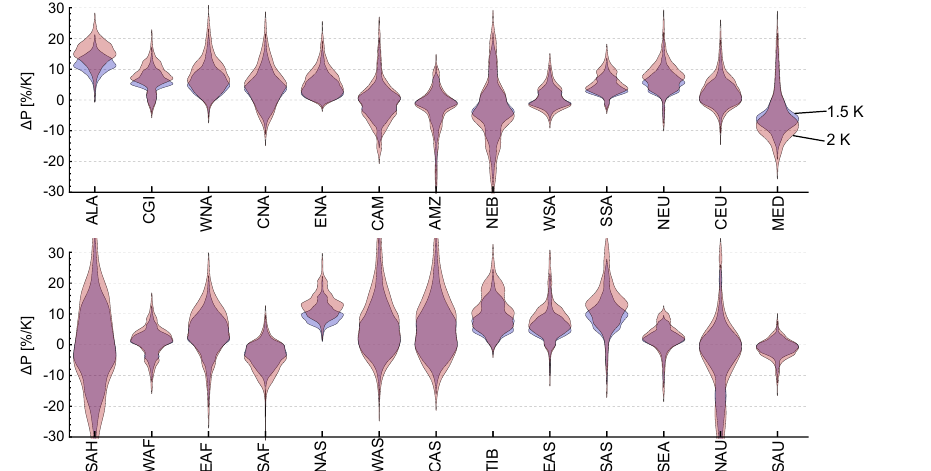
Figure 10. Uncertainty distributions (shown as violin plots) of the sensitivity of P to global mean temperature change for two different degrees of global mean temperature change, which correspond to the widely used warming-degree limits of 1.5 and 2K. The estimates are averaged over all SREX regions (as outlined in Fig. 3 and Table 2).